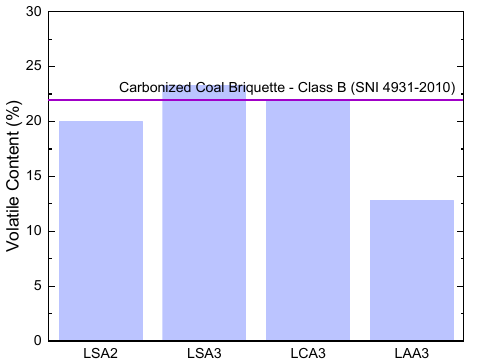
Figure 4. Volatile content of lignin LSA2, LSA3, LCA3, and LAA3 with carbonized coal briquette SNI (4931–2010).